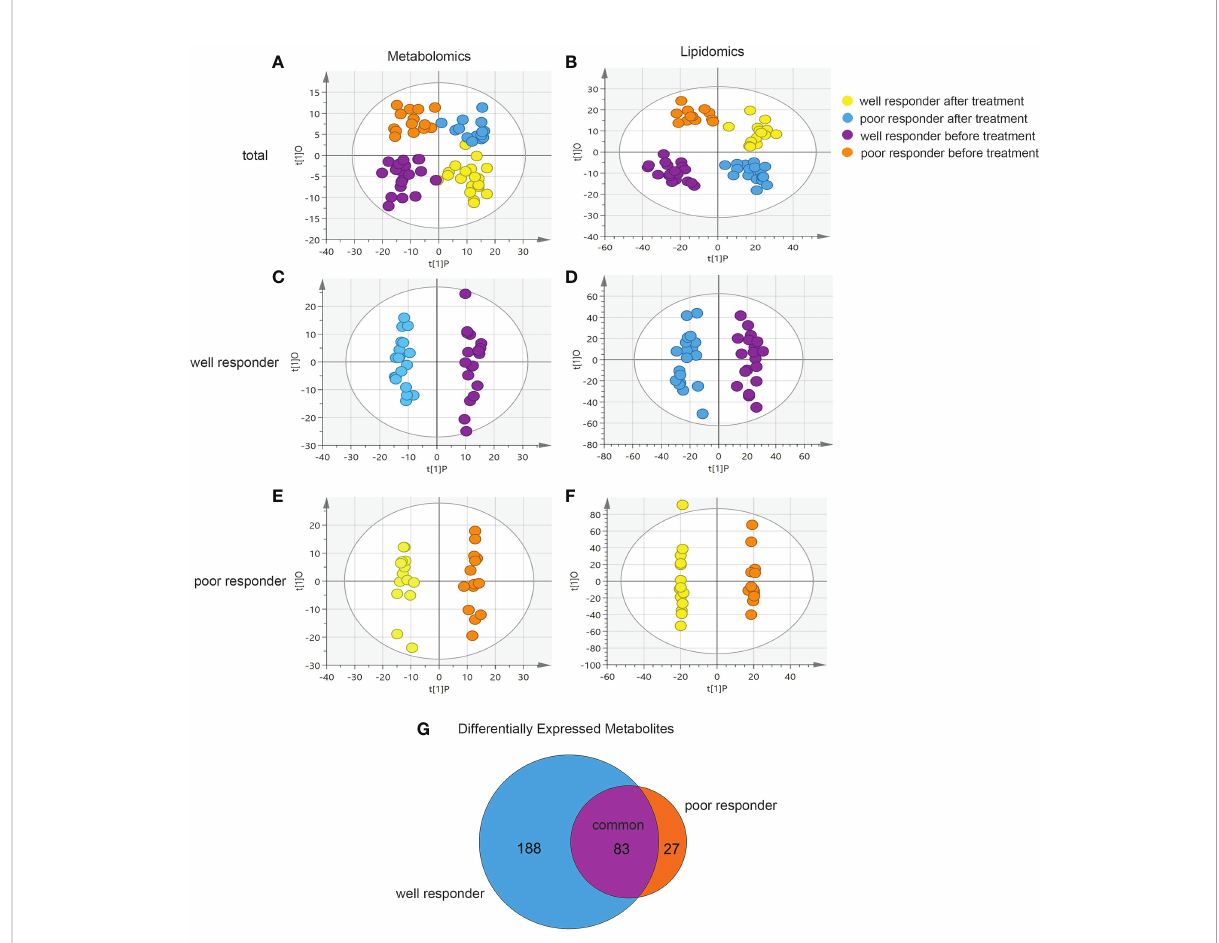
FIGURE 3 Differential between well responder and poor responder to dupilumab treatment based on metabolomics and lipidomics. (A, B) Orthogonal partial least squares discriminant analysis (OPLS-DA) model comparing metabolomics and lipidomics fi ngerprints of samples belonging to different group (well responder before treatment, poor responder after treatment, well responder before treatment and poor responder before treatment). The model parameters were R 2 Y = 0.558 and Q 2 = 0.227 in metabolomics analysis and R 2 Y = 0.609 and Q 2 = 0.305 in lipidomics analysis. (C, D) OPLS-DA model for well responder group. The model parameters were R 2 Y = 0.977 and Q 2 = 0.736 in metabolomics analysis and R 2 Y = 0.948 and Q 2 = 0.754 in lipidomics analysis. (E, F) OPLS-DA model for poor responder group. The model parameters were R 2 Y